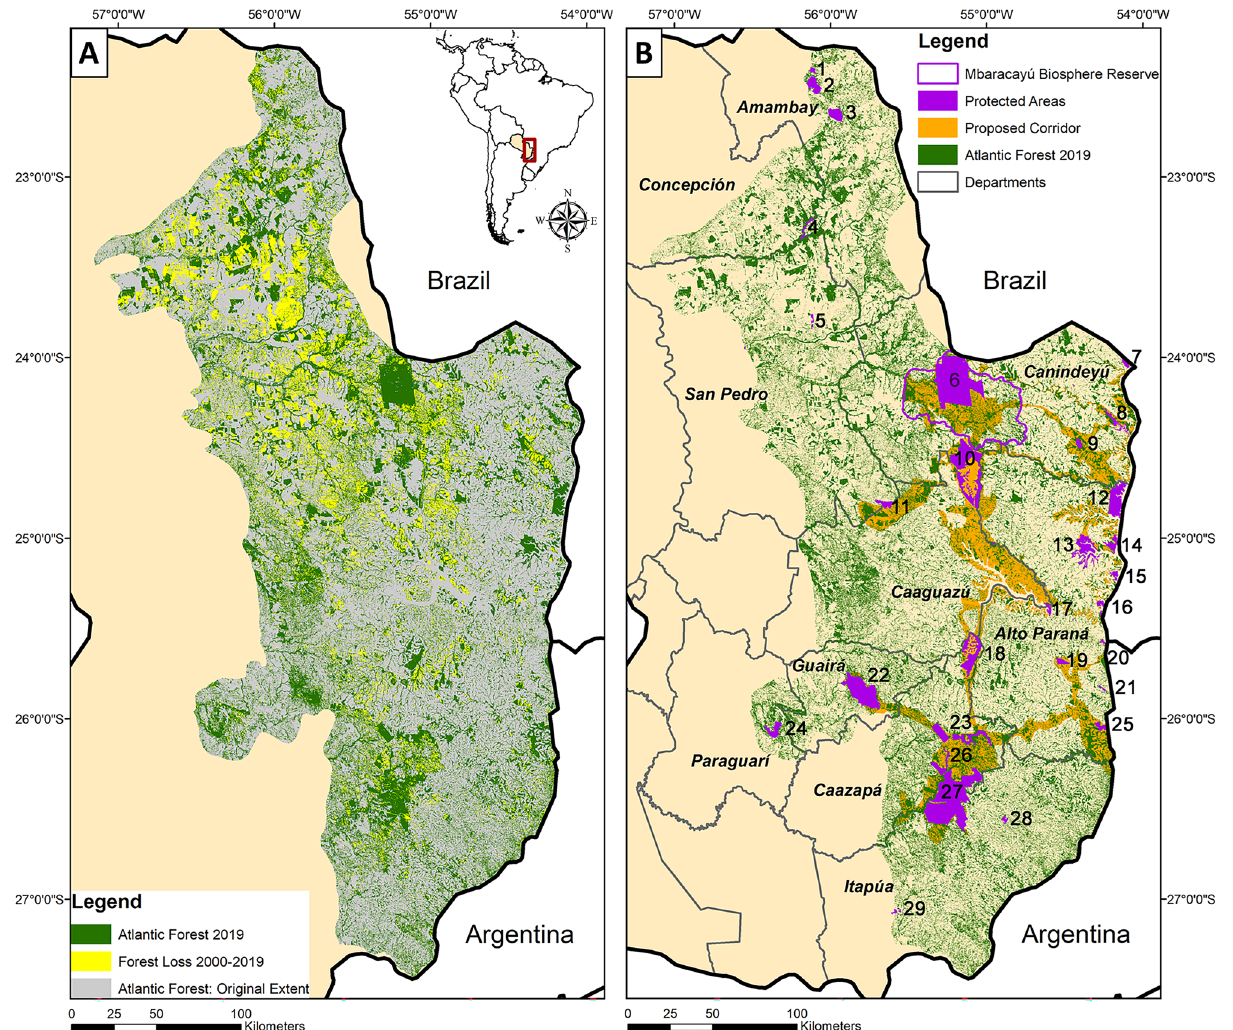
Figure 1. ( A ) Map of the original extent of the Atlantic Forest in Paraguay (gray; from Olson et al. 46 ) with the extent of forest remaining in 2019 (green), and the amount of forest lost between 2000 and 2019 (yellow; Hansen et al. 21 ). ( B ) Map of the 2019 Atlantic Forest in Paraguay, with currently recognized protected areas (UNEP-WCMC and IUCN 2020), proposed Paraguay Biodiversity Corridor (PBC, sensu Esquivel et al. 29 ), and the 2019 forest cover. The protected areas are: (1) Estrella Reserve; (2) Arroyo Blanco Reserve; (3) Cerro Corá National Park; (4) Kaí Rague Private Nature Reserve; (5) Laguna Blanca Reserve; (6) Mbaracayú Forest Nature Reserve; (7) Mbaracayú Binational Nature Reserve; (8) Carapá Nature Reserve; (9) Itabó Ecological Reserve; (10) Morombí Nature Reserve; (11) Capiibary Ecological Reserve; (12) Limoy Nature Reserve; (13) Itabó Biological Reserve; (14) Yvyty Rókai Nature Reserve; (15) Pykyry Nature Reserve; (16) Tati Yupi Nature Reserve; (17) Yguazú Nature Reserve; (18) Ypeti Nature Reserve; (19) National Monument Kuri’y; (20) Maharashi Nature Reserve and Moises Bertoni Scientific Monument; (21) Tabucai Nature Reserve; (22) Ybytyruzu Management Reserve; (23) Caazapá National Park; (24) Ybycuí National Park; (25) Ñacunday National Park; (26) Tapyta Nature Reserve; (27) San Rafael National Park; (28) Edelira Managed Resource Reserve; (29) Cuenca del Arroyo Tacuary Chopy Sayju Nature Reserve. Maps were generated in ArcGIS 10.7 71